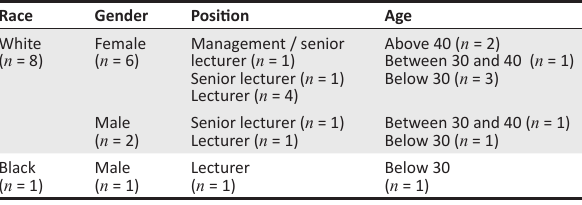
TABLE 1: Biographical information of the sample ( N =